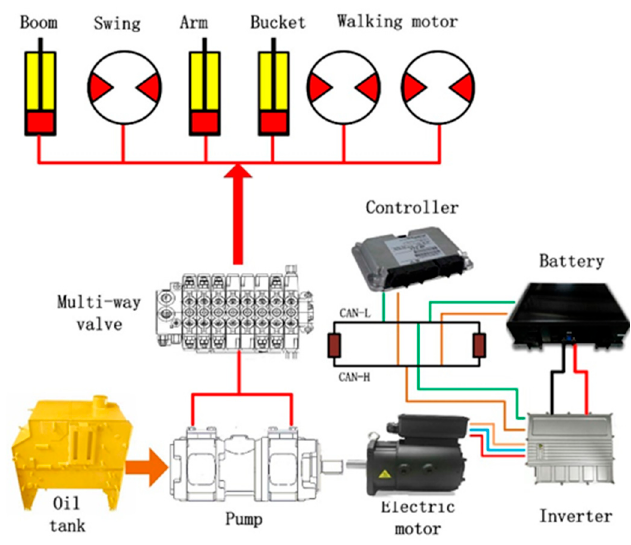
Figure 1. System structure.